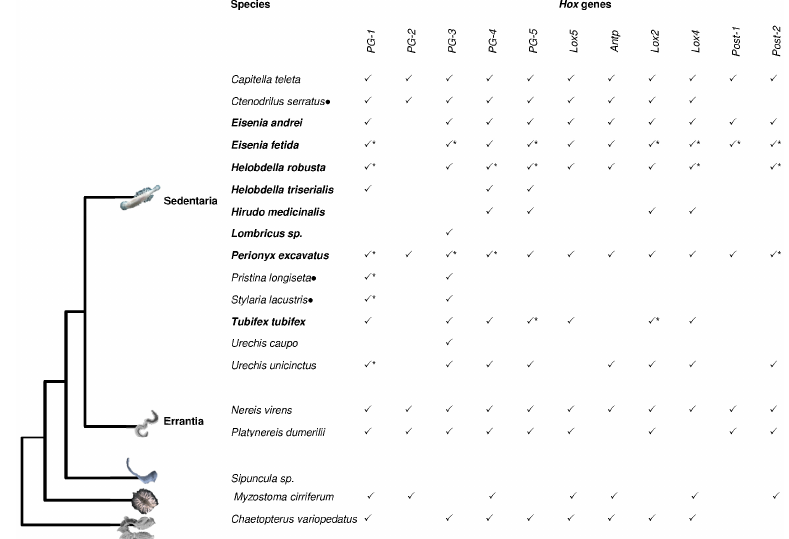
Figure 2. Hox genes in Annelida. Hox genes identified in the Annelida phylum are reported. Tree topology following Struck et al. [95]. * indicates duplicated genes. Black dots indicate species not included in the analysis carried out by Struck et al. [95]. Species in bold belong to Clitellata. For references see Table S2.